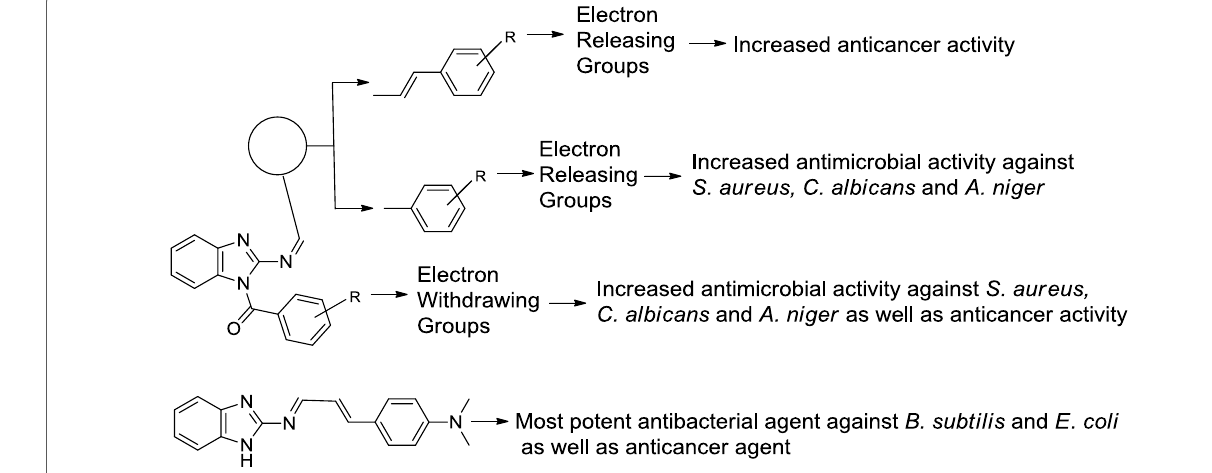
Fig. 1 Structural requirements for antimicrobial and anticancer activity of synthesized benzimidazole